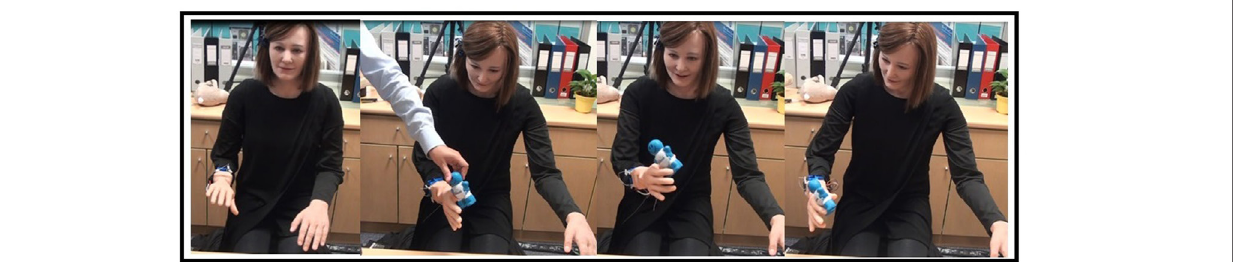
FigUre 11 | Four intermediate actions of the virtual Nadine and four screenshots of the Nadine robot grasp test (Magnenat Thalmann et al., 2017).